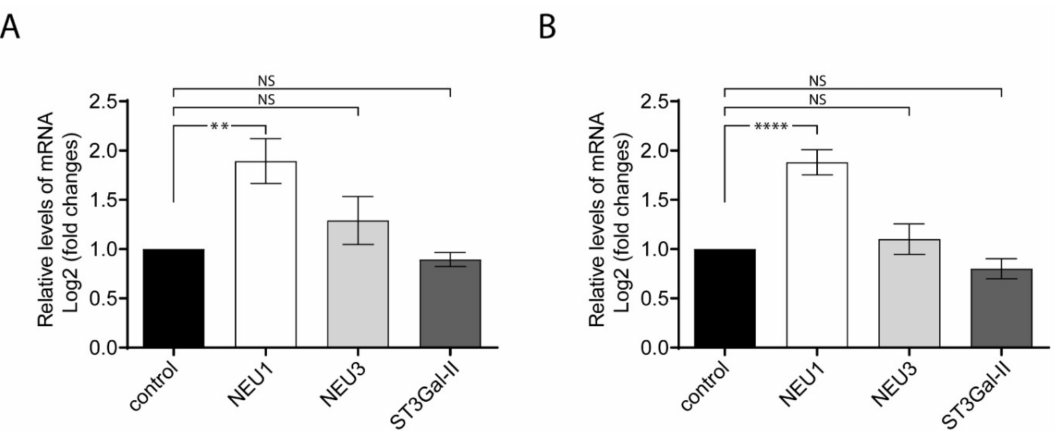
Figure 4. The relative levels of NEU1, NEU3 and ST3Gal-II transcripts analyzed by RT-qPCR. Total RNA was purified and reverse-transcribed from RAW264.7 cells stimulated and non-stimulated with LPS. mRNA levels were quantified by RT-qPCR using specific primers. The expression values for the RT-qPCR are given relative to the expression levels of 18S rRNA and Tbp (TATA-box-binding protein) gene ( A and B , respectively) and were expressed as Log2 fold change. Data are expressed as mean ± S.E.M. from at least three independent experiments, each in triplicate. (** p < 0.005; **** p < 0.0001). 2.5. NO Formation is Involved in the Expression / Localization of ST8Sia-I at the Plasma